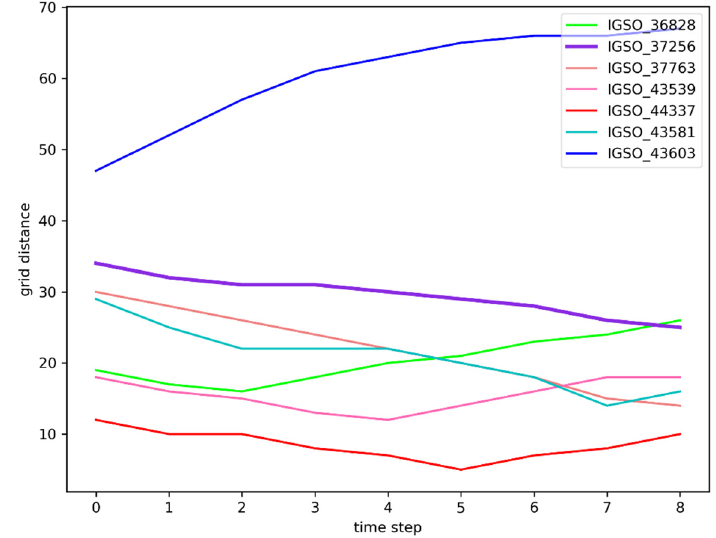
Figure 8. Grid calculation results for different satellites.